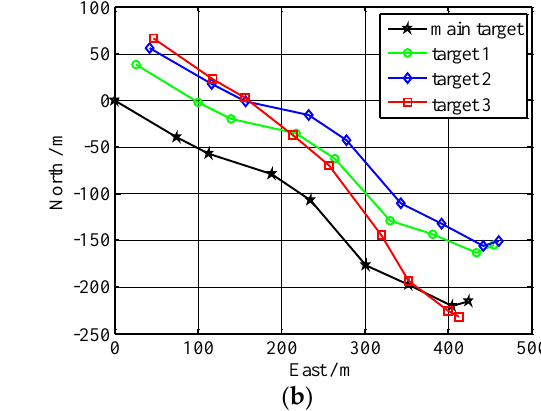
Figure 18. Ortho image of the Changji highway in aerial imagery.